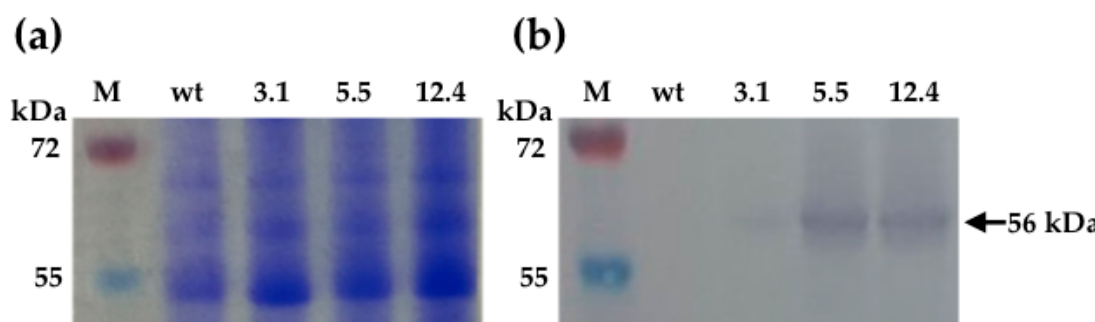
Figure 3. Detection of SmChiC protein in tobacco leaf extracts subjected to immunoblot analysis by Western blot. ( a ) SDS-PAGE analysis of crude leaf extracts, homozygous transgenic tobacco lines 3.1, 5.5 and 12.4; wt wild-type plant (negative control); M, protein molecular weight marker. ( b ) Western blot assay of crude leaf extracts revealing a band of 56 kDa corresponding to SmChiC endochitinase.